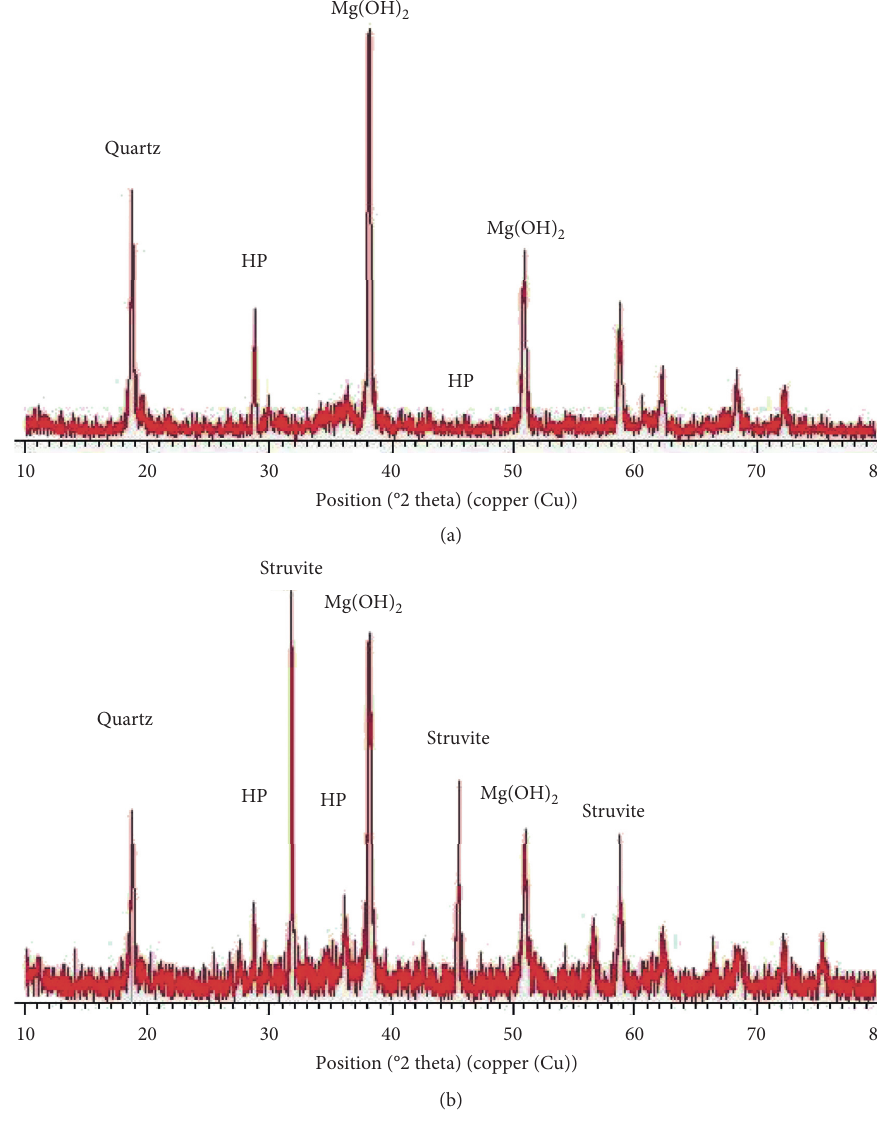
Figure 6: XRD analysis of (a) MB and (b) MPB